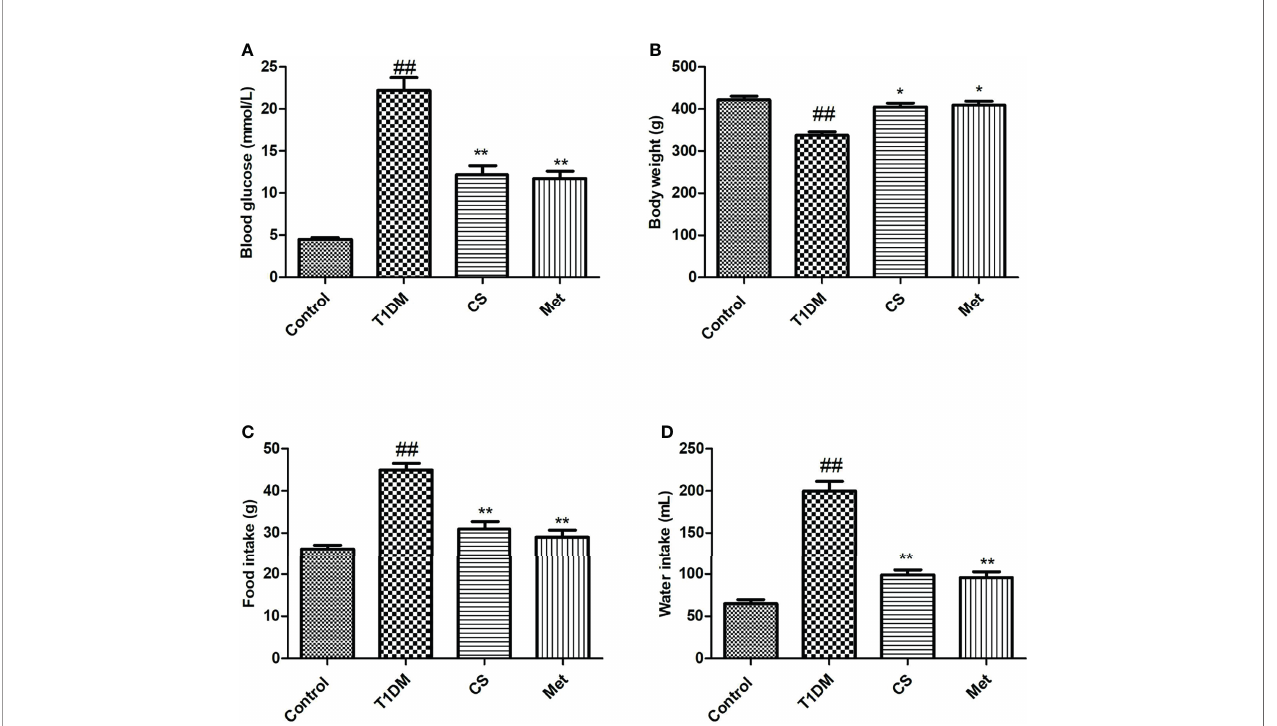
FIGURE 1 | Blood glucose, body weight, food intake, and water intake at the end of the 10th week in different groups. (A) Blood glucose in different groups. (B) Body weight in different groups. (C) Food intake in different groups. (D) Water intake in different groups. ## indicates p < 0.01 compared with control; **indicates p < 0.01 compared with the diabetic group; *indicates p < 0.05 compared with the diabetic